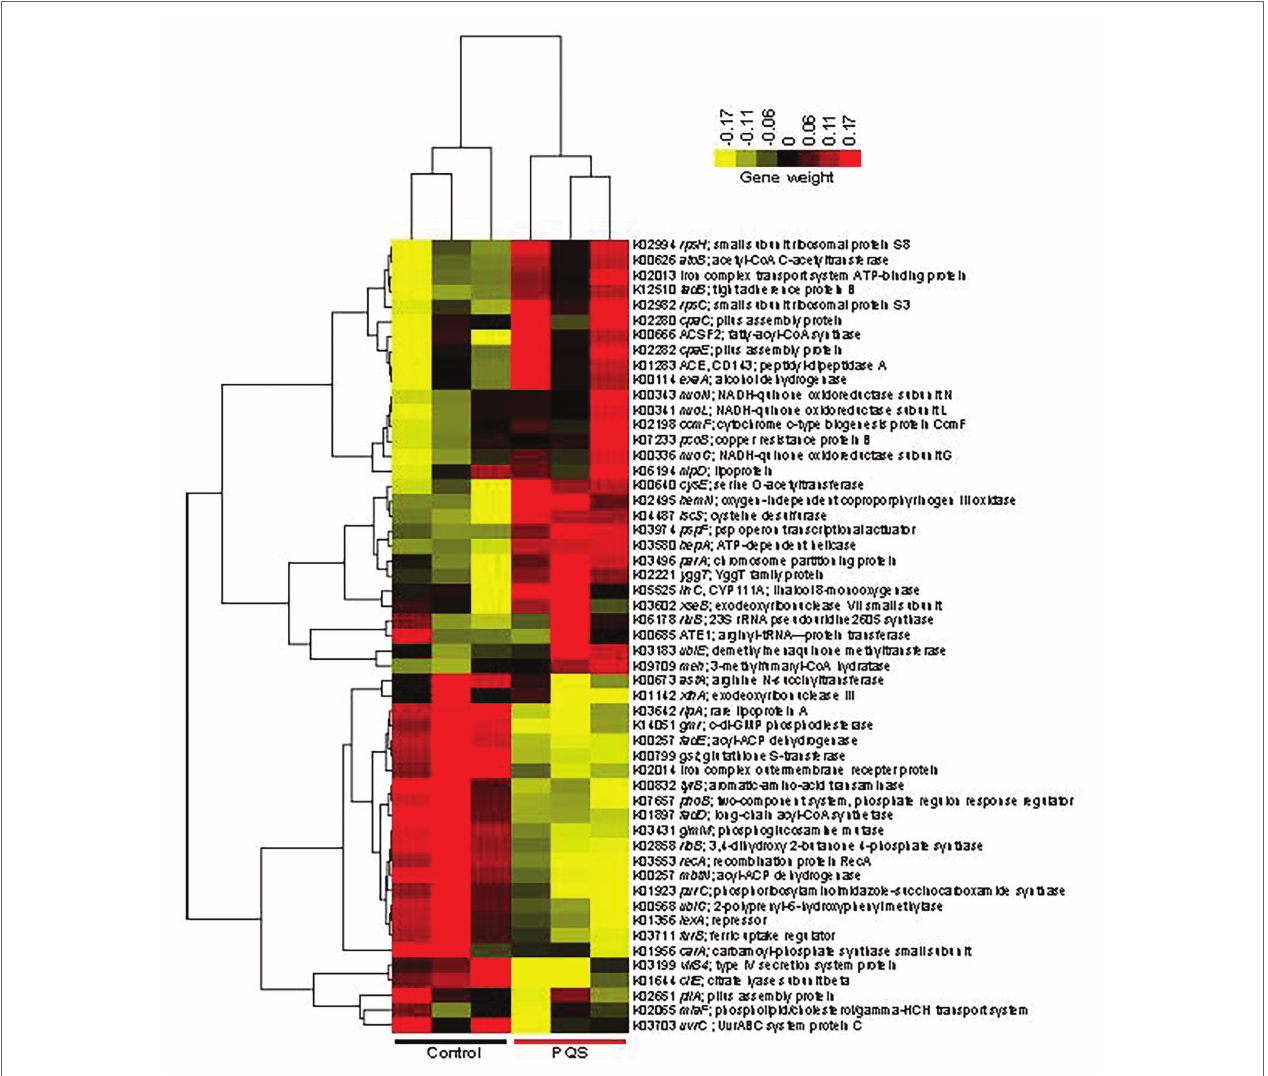
FIGURE 4 | Heatmap showing the differentially expressed genes between the PQS-treated biofilms and the control biofilms of Erythrobacter sp. HKB8. A p -value cutoff of 0.01 in a two-tailed Student’s t -test was used to select the significantly changed genes. Then, the transcripts per million (TPMs) of genes that could be annotated by the Kyoto Encyclopedia of Genes and Genomes (KEGG) database were used to plot the